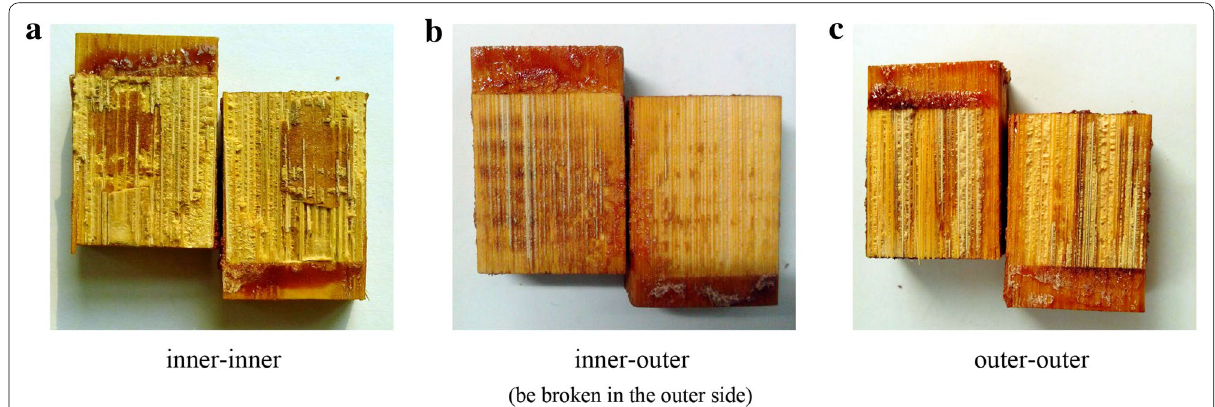
Fig. 3 Fracture topography of bamboo samples after compression shear test